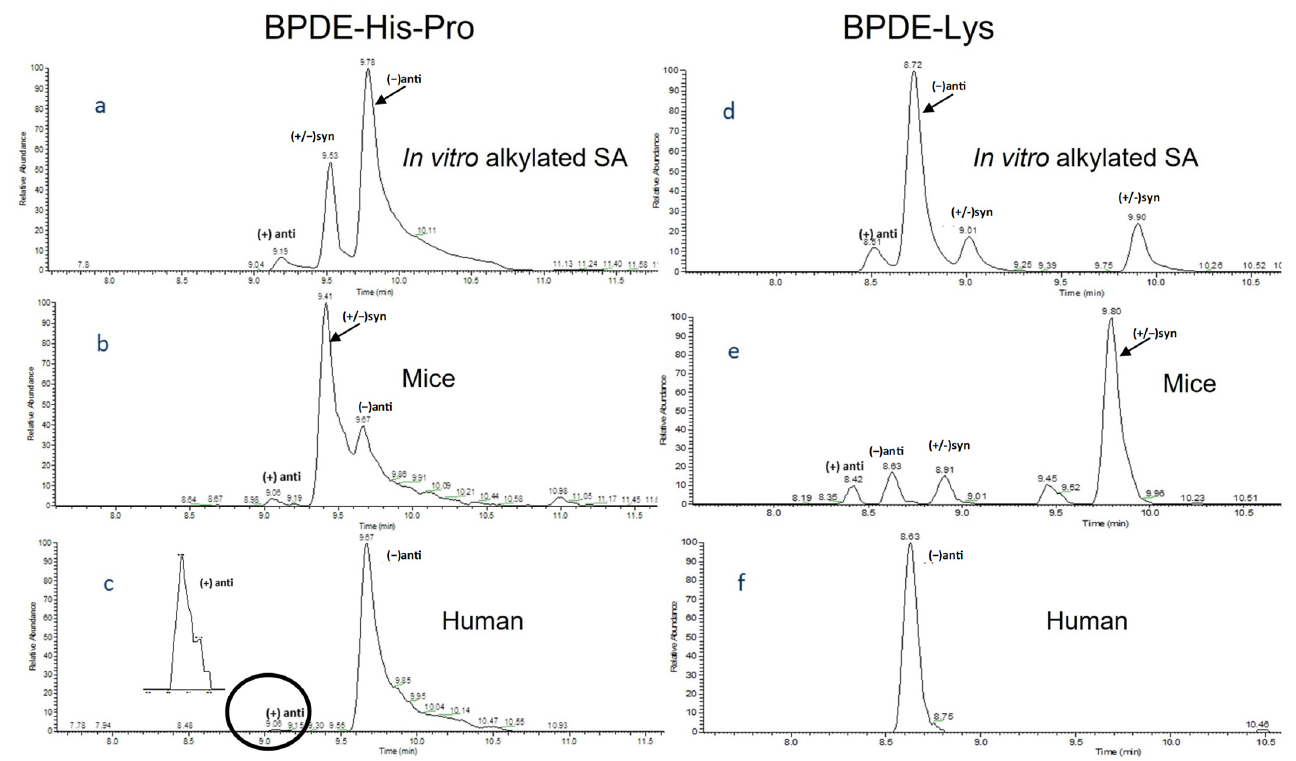
Figure 3. Extracted ion chromatograms showing separation of the studied adducts on an F5 HPLC column and using Orbitrap tandem HRMS (PRM mode). ( a ) BPDE-His-Pro from in vitro alkylated SA (1 mg); ( b ) BPDE-His-Pro from 10 mg SA of benzo[ a ]pyrene-treated mice (100 mg/kg of body weight) 1 day after exposure; ( c ) BPDE-His-Pro in human SA (10 mg) in vivo; in ( d – f ) are shown corresponding chromatograms for BPDE-Lys. The inset of Figure 3c shows a × 40 magnification of the peak corresponding to (+)-anti-BPDE-His-Pro (for retention times, see also Table 2). circled region shows the peak corresponding to